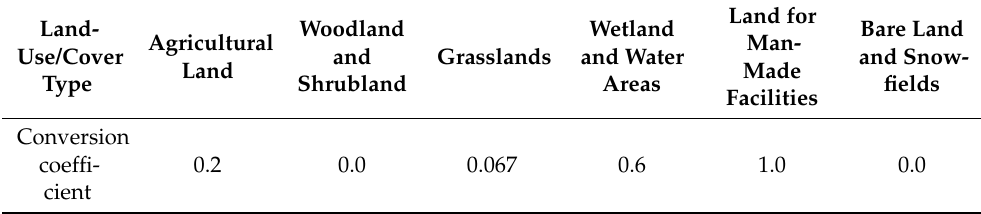
Table 2. Conversion coefficients of impervious surface equivalents for different land-use